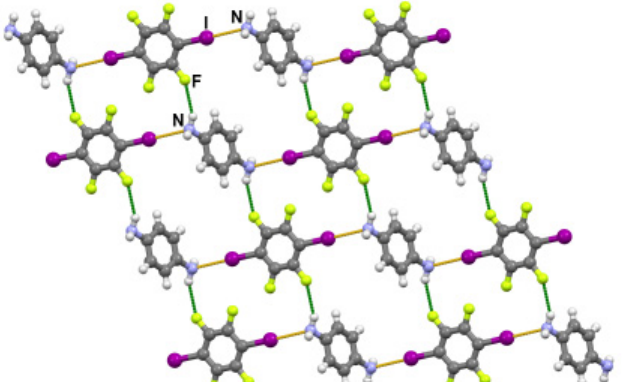
Figure 1. In the structure of ( pphda )( 14tfib ), layers are formed by the linking of halogen bonded (yellow) chains through N − H ⋯ F hydrogen bonds (green) in the structure of ( pphda )( 14tfib ). o -Tolidine was found to form two cocrystals: ( otol )( 14tfib ) and ( otol )( 135tfib ) 2 . The halogen bonding in the crystal structure of the former is analogous to that in ( pphda )( 14tfib )—each diamine is connected to the neighbouring donor molecules by a pair of I···NH 2 halogen bonds, although these are somewhat longer than in ( pphda )( 14tfib ) ( d (I1···N1) = 2.977(4) Å, ∠ (C8–I1···N1) = 176.8(1)°) (Figure 2). The amine hydrogen atoms here also interact with fluorine atoms from the surrounding 14tfib molecules, through a series of bifurcated N–H ⋯ F contacts ( d (N1···F1) = 3.334(5) Å, d (N1···F2) = 3.273(4) Å), again interconnecting the halogen-bonded chains into layers (Figure 2). Additionally, the otol methyl groups participate in C–H ⋯ π contacts ( d (C7···C4) = 3.607(6) Å) which interconnect the layers into a 3D structure.